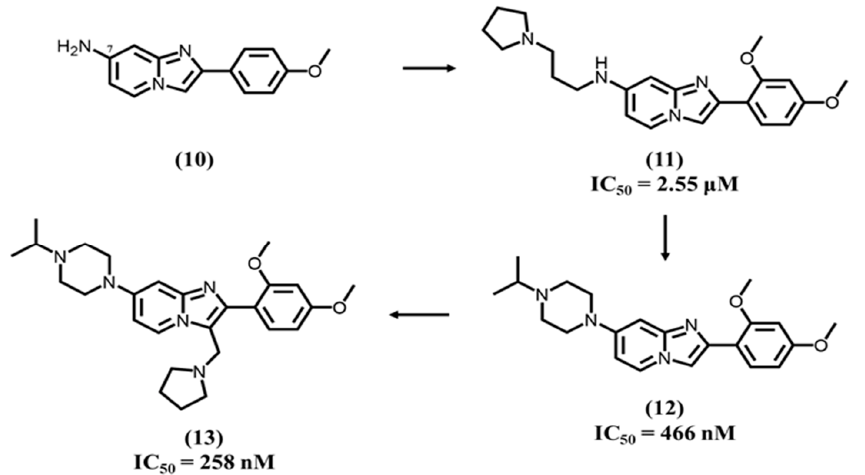
Figure 4. SAR studies on imidazopyridine derivatives.